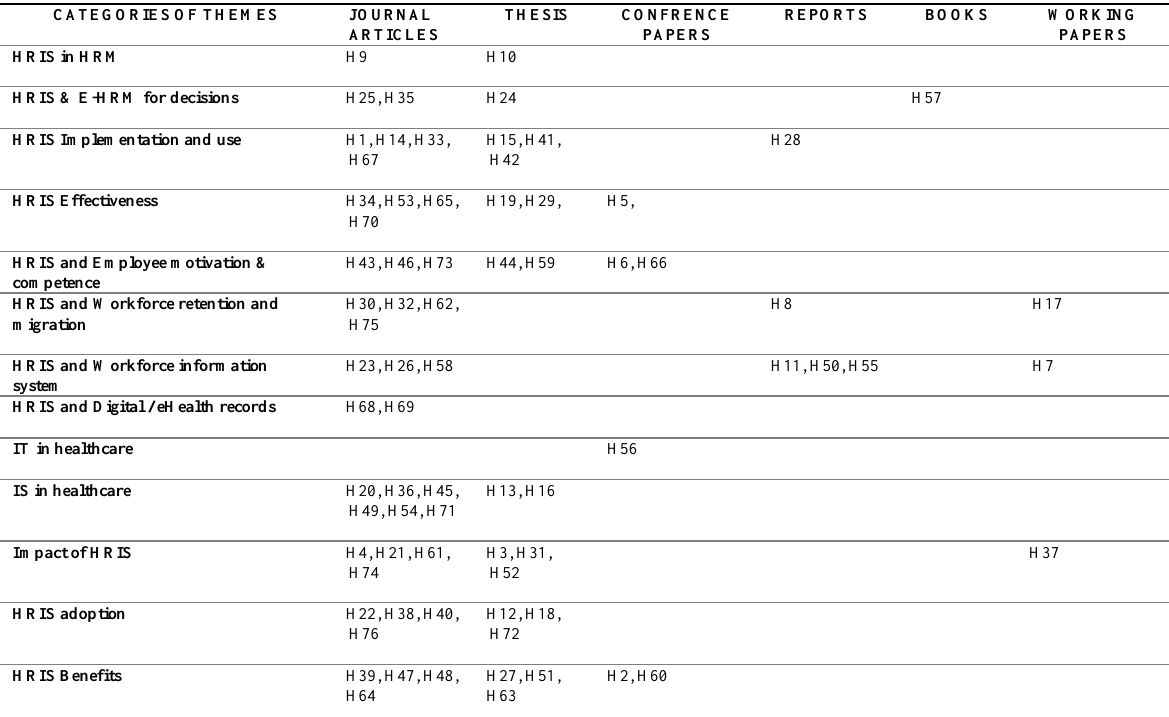
Table 1: Summary of